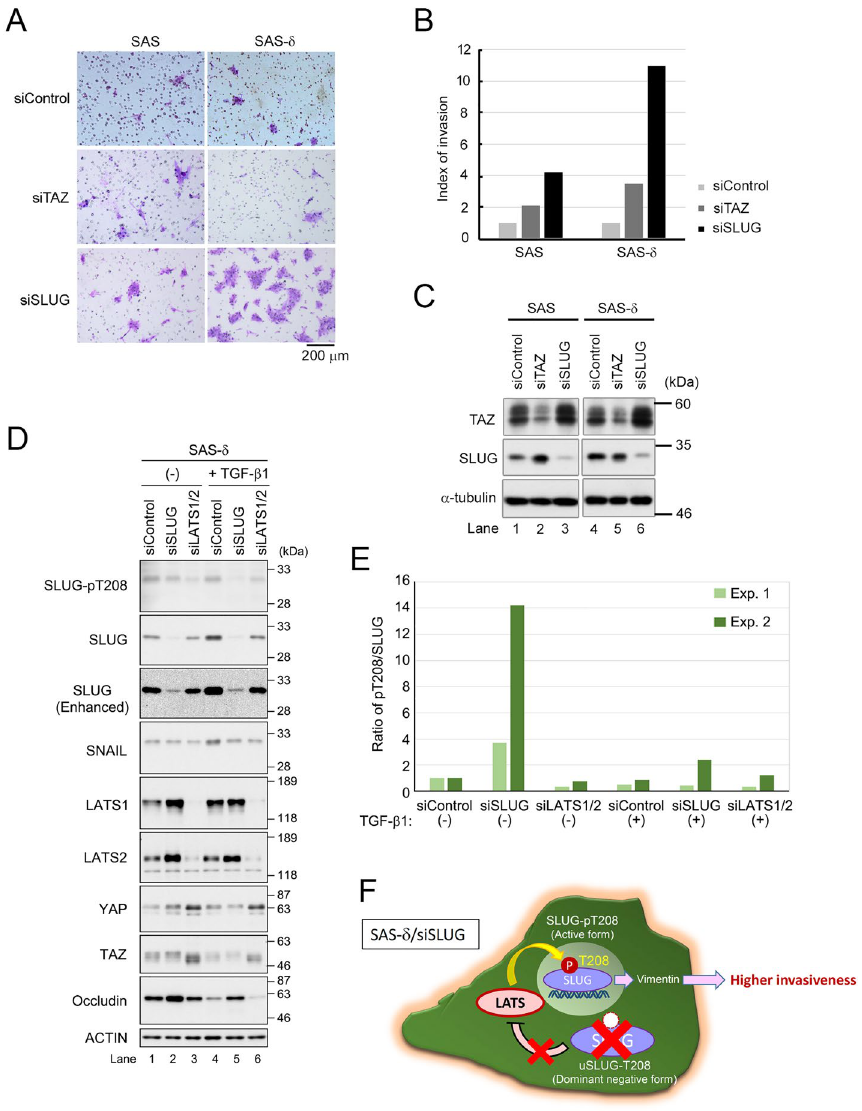
Figure 6. Downregulation of SLUG enhances in vitro invasiveness of SAS-δ via activation of the LATS1/2– SLUG-pT208 axis. ( A ) Invasion assays of parental SAS and SAS-δ transfected with siRNAs against TAZ, SLUG or siControl (negative control) were performed in the absence of TGF-β1 as in Fig. 2A. Invading cells on the membrane were stained, and then the membranes were photographed using a digital camera. ( B ) Bar graphs showing the index of invasion in ( A ), calculated by dividing the percent of invasion (% invasion = the average number of invading cells / the average number of migrating cells × 100) of parental SAS or SAS-δ cells transfected with the indicated siRNAs by the percent invasion of cells transfected with siControl. ( C ) WB of lysates from siRNA-treated cells used in the invasion assays. α-tubulin was used as a loading control. ( D ) SAS-δ cells were transfected with siSLUG, siLATS1/2 or siControl, and then cultured in the presence (+) or absence (–) of TGF-β1 (10 ng/ml) for 48 h, followed by WB with the indicated antibodies. Actin was used as a loading control. ( E ) Bar graph showing the ratio of SLUG-pT208 to total SLUG protein in SAS-δ transfected with siSLUG or siLATS1/2 in the presence (+) or absence (–) of TGF-β1 (10 ng/ml) for 48 h. Two experiments (Exp. 1 and 2, corresponding to those shown in ( D ) and Fig. S6A, respectively) were performed independently. ( F ) A speculated model for the molecular mechanism by which downregulation of SLUG promotes accumulation of T208-phosphorylated SLUG via LATS1/2 activation in SAS-δ. Knockdown of SLUG in SAS-δ increases LATS1/2, thereby efficiently phosphorylating residual SLUG protein on T208 for enhancing the invasiveness of the